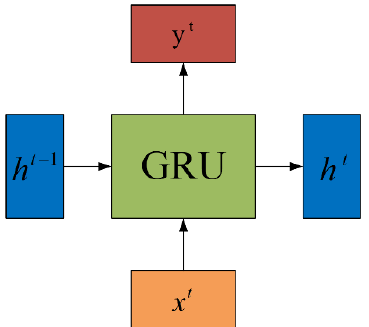
Figure 2. Input/output structure of